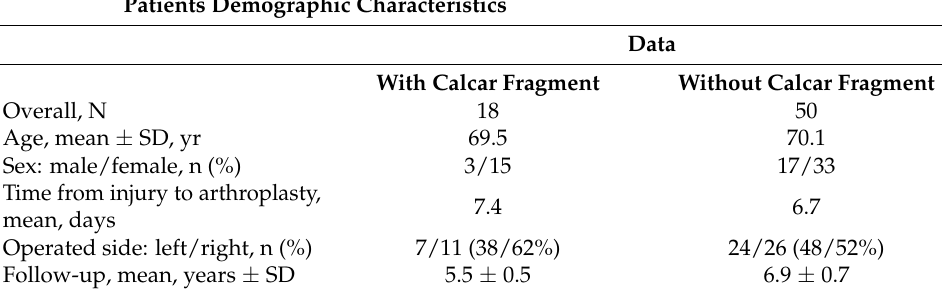
Table 1. Characteristics of study population. Patients Demographic Characteristics